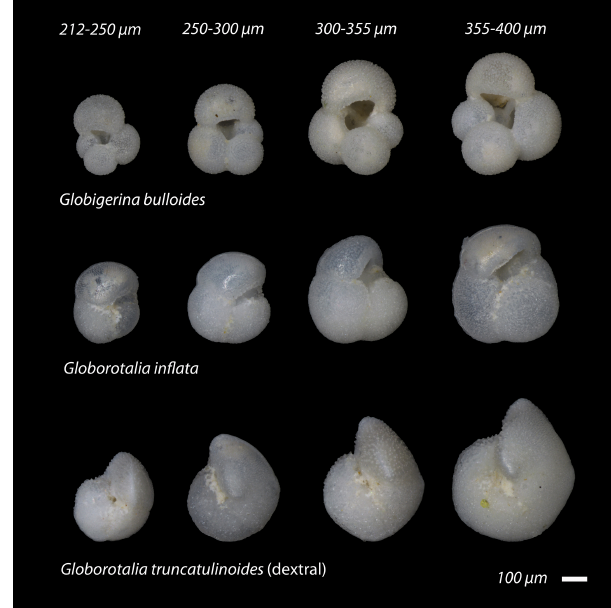
Figure 2. Taxonomy and size of species analysed in this paper. Apertural view of the “surface dweller” Globigerina bulloides (top row), “intermediate dweller” Globorotalia inflata (middle row) and the “deep dweller” Globorotalia truncatulinoides (bottom row)for the size fractions 212–250, 250–300, 300–355 and 355–400µm from a 756cm depth core. Scale bar (100µm) is the same for all images, highlighting the offset between the various size